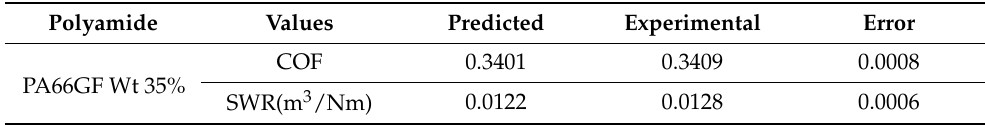
Table 4. Validation experiments of COF and SWR for PA66